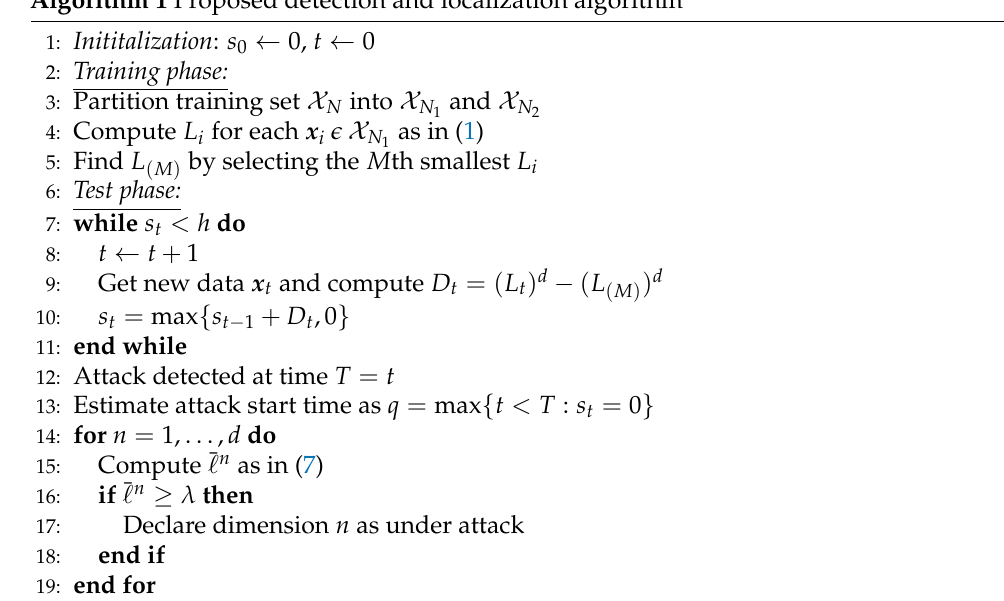
Algorithm 1 Proposed detection and localization